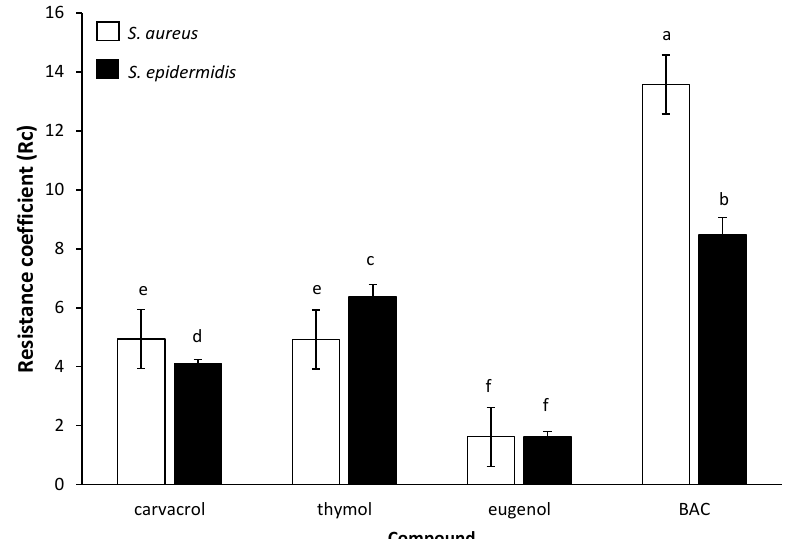
Figure 4. Resistance coe ffi cients (Rc) of each compound for each bacterial species ( (cid:3) S. aureus ; (cid:4) S. epidermidis ). The bars represent the mean values ± standard deviations. Mean values sharing at least one common letter shown above the bars are not significantly di ff erent ( p > 0.05).